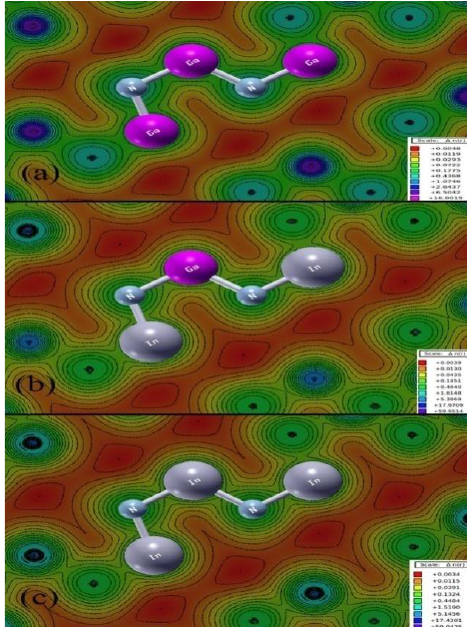
Fig. 4. Electron density for (a) GaN (b) In Ga N 0.5 0.5 InNalong [110] direction for WZ